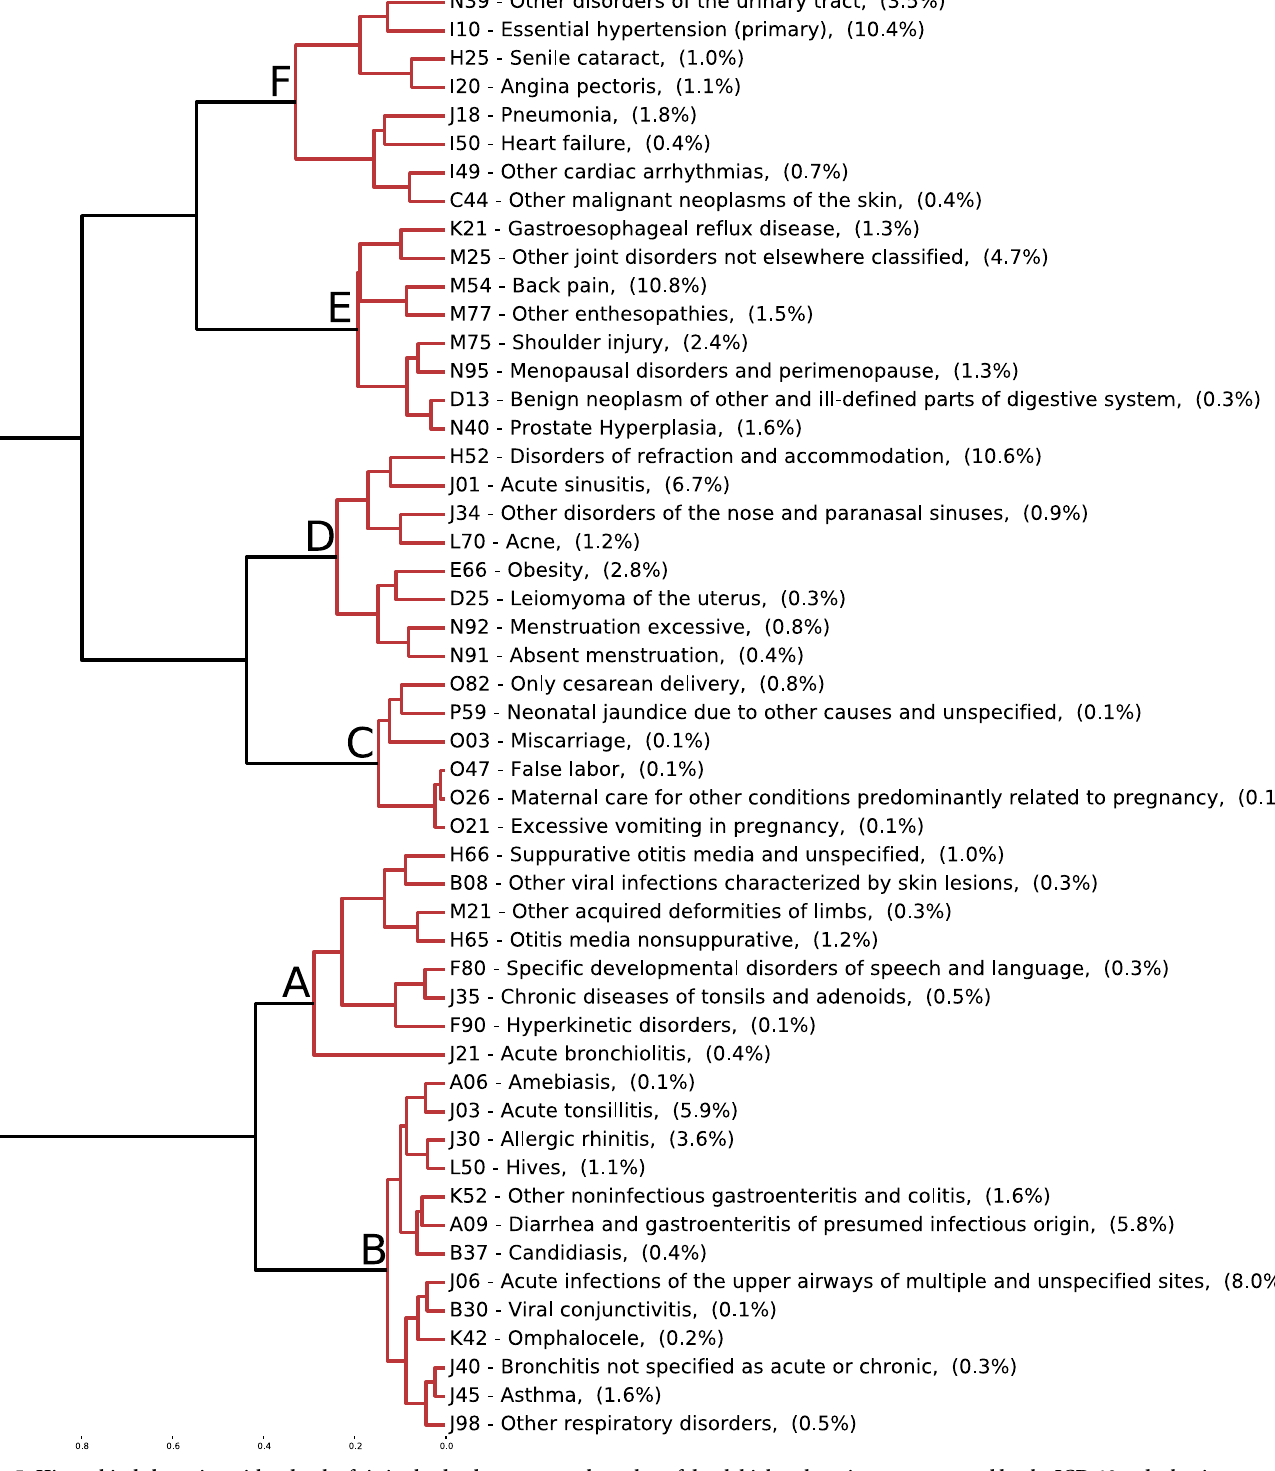
Fig 5. Hierarchical clustering with a depth of six in the dendrogram tree, branches of depth higher than six are represented by the ICD-10 code that is most common in that branch. The frequency of each ICD-10 code is in parenthesis in percentage of the total population of patients. The alphabet letters assignments correspond to the clusters discussed in Fig